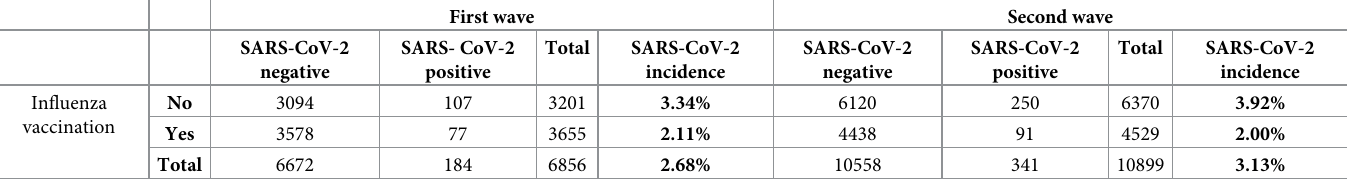
Table 1. COVID-19 incidence among influenza vaccinated and unvaccinated employees of Radboud University Medical Center in the first two waves of the pan- demic. First wave: March—June 2020, second wave: November 2020—January 2021. Influenza vaccinations in autumn of 2019 and autumn of 2020 were considered for calculations regarding the first and the second COVID-19 waves, respectively.